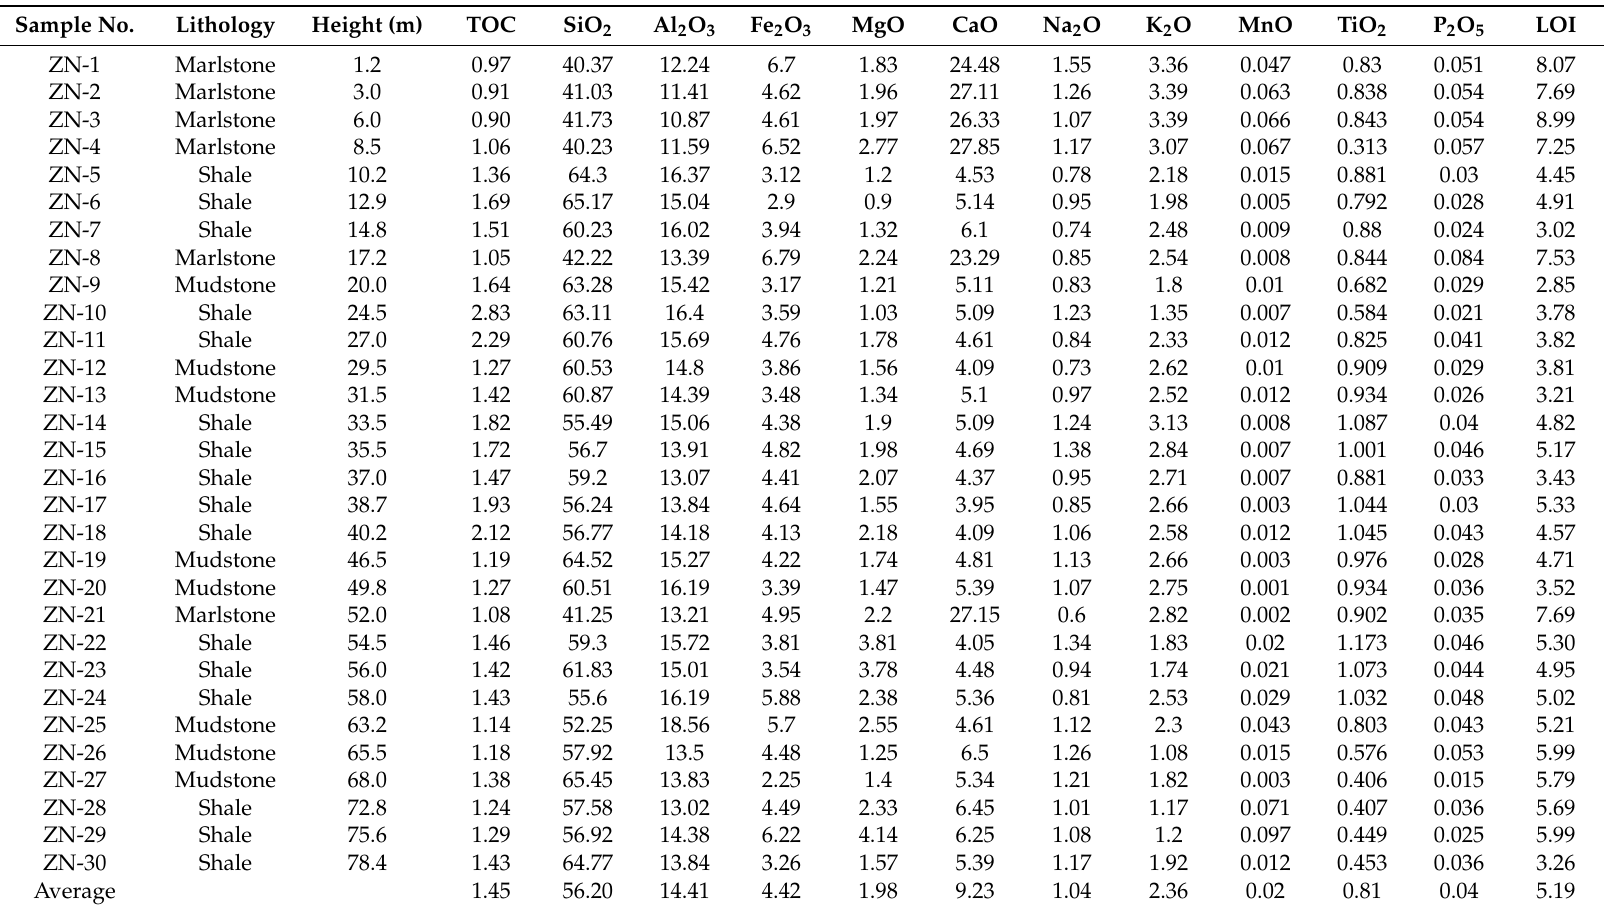
Table 1. TOC, major element concentrations and their geochemical indicators of the target samples from Zhenning section (unit: wt%). Sample